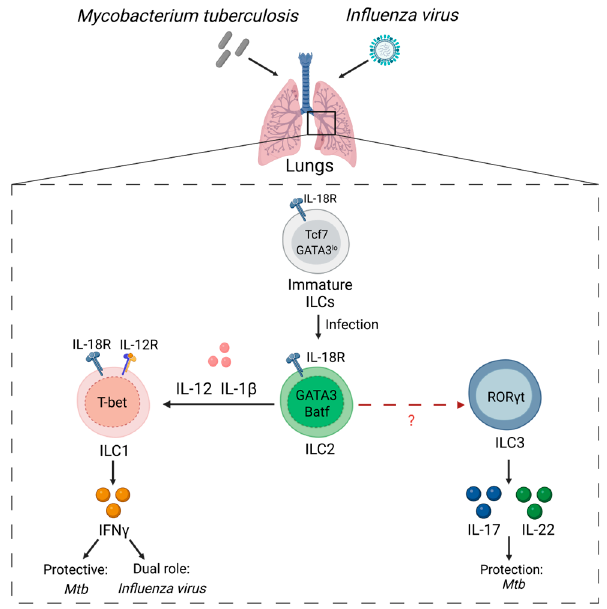
Figure 5. ILC plasticity in response to lung infections. In steady state lungs contain tissue-resident immature IL-18R + TCF1 + GATA3 lo ILCs which can differentiate into ILC2s. Respiratory infections facilitate maturation of IL-18R + ILCs. Type 1 inflammatory cytokines (IL-12+IL-1 β ) drive ILC2 → ILC1 plasticity by downregulating GATA3 and upregulating T-bet. T-bet induces production of IFN γ by ILC1s. Additionally, IL-22 and IL-17 produced by ILC3s support protective responses via iBALT maintenance.